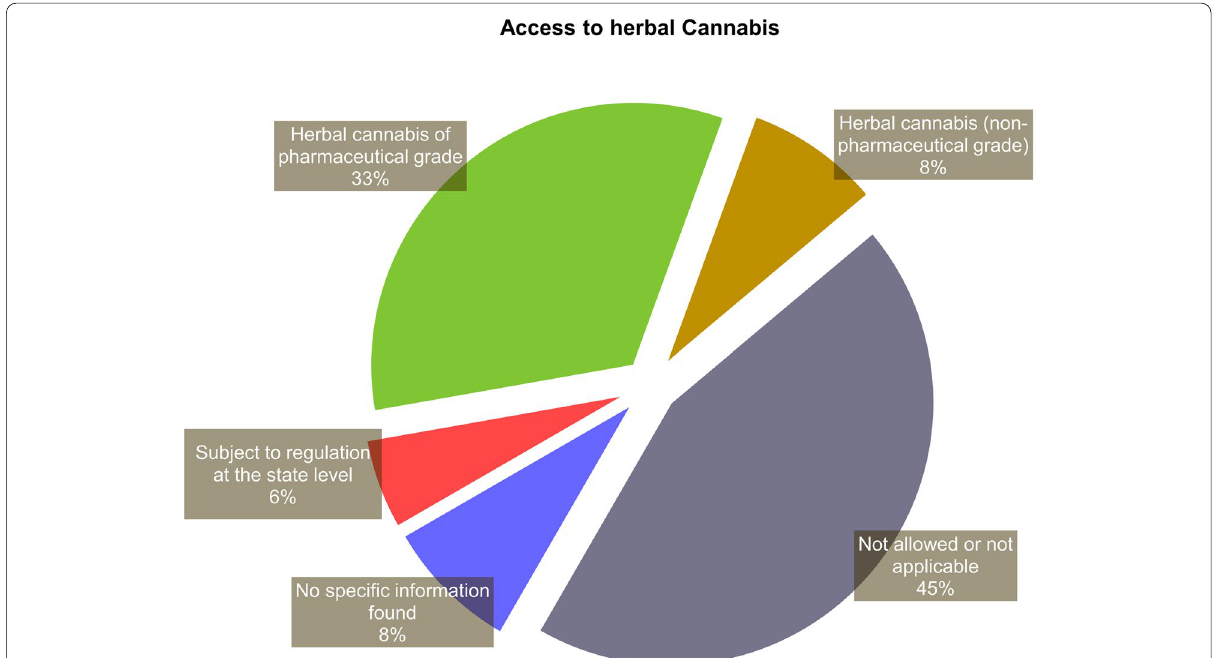
Fig. 3 Classification of the assessed regulatory models with regard to the possibility of access to herbal cannabis. The classification is based on data obtained from October 2020 to March 2021. The sources of the original information regarding the assessed models are listed in the supplementary material